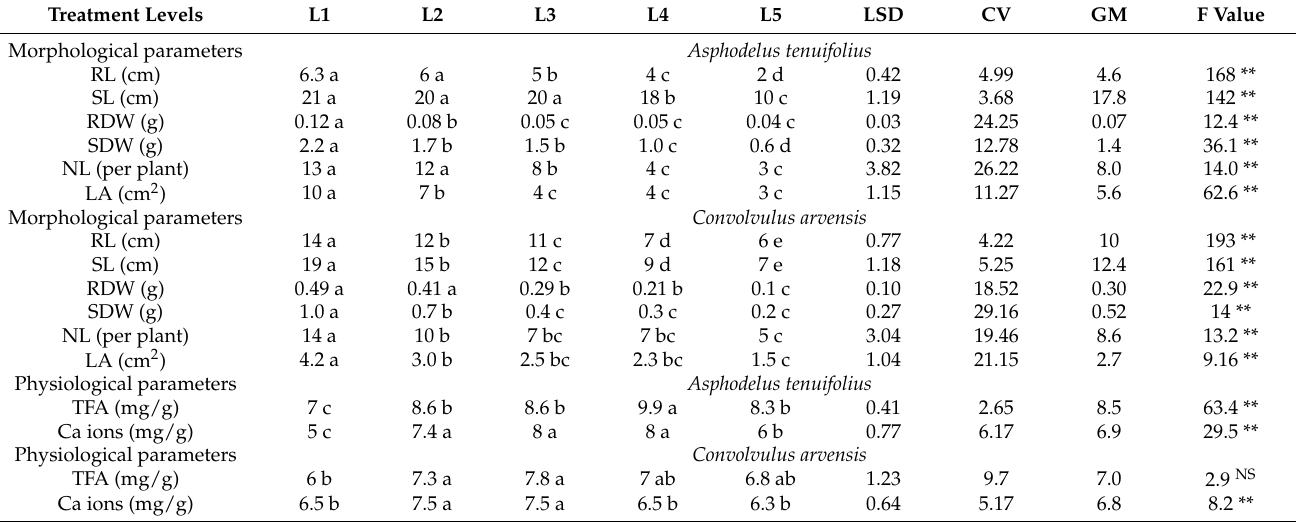
Table 1. ANOVA for the influence of shoot extract of Trianthema portulacastrum and herbicide on morphological and physiological parameters of Asphodelus tenuifolius and Convolvulus arvensis at the vegetative